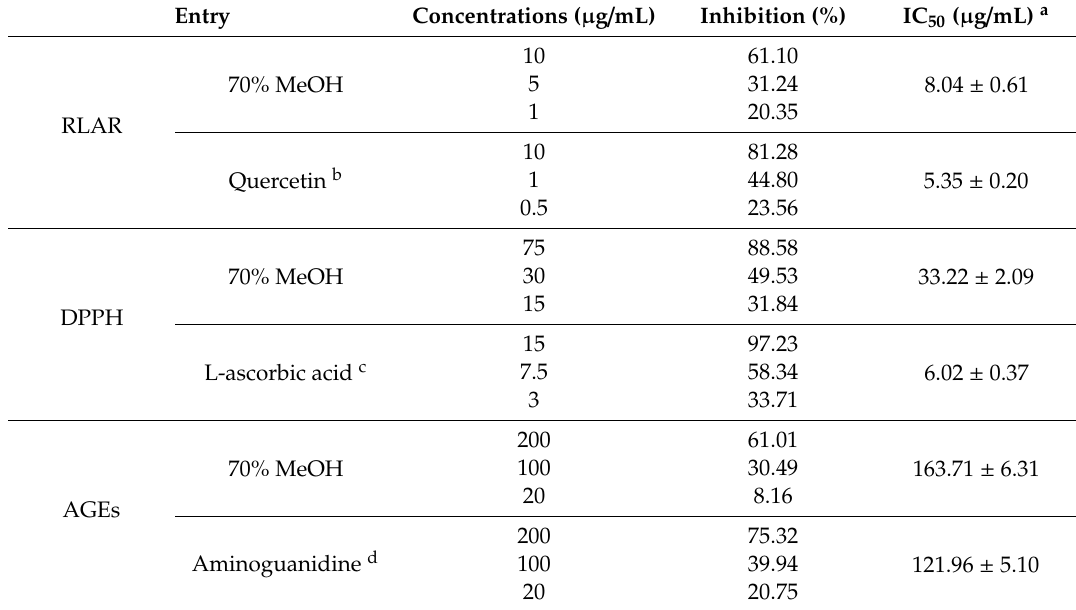
Table 2. The inhibitory e ff ects of Tanacetum parthenium L. extract on RLAR, DPPH radical scavenging activity, and advanced glycation end products